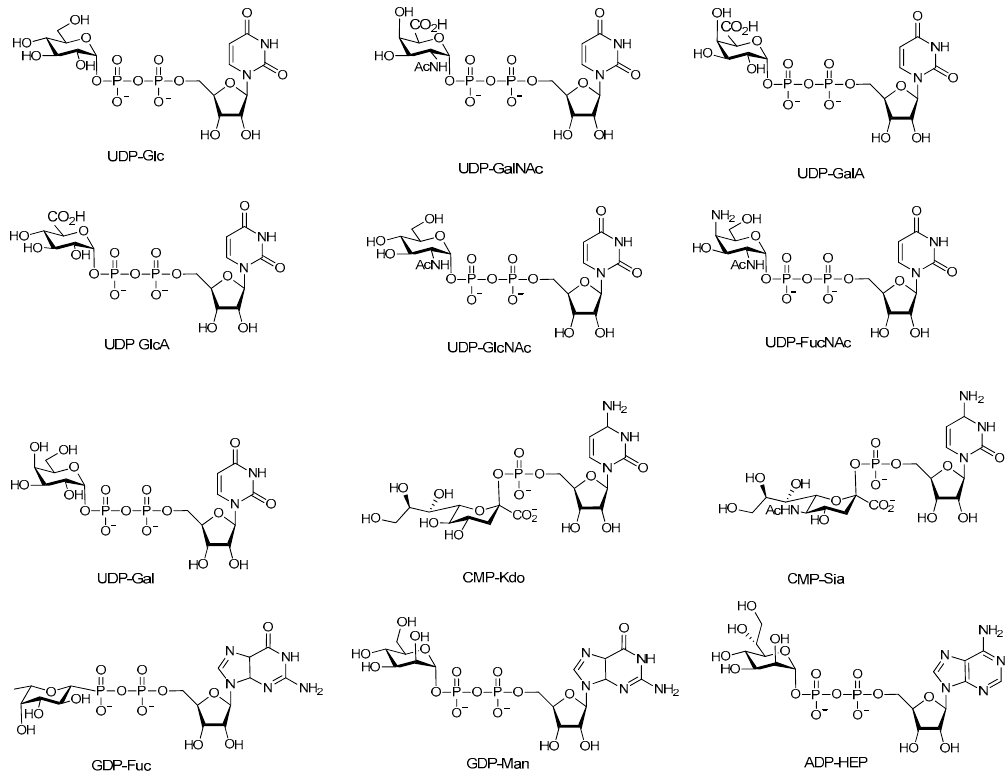
Figure 2. Common sugar nucleotides found in all kingdoms of life. Abbreviations: UDP-Glc, UDP-glucose; UDP-GalNAc, UDP- N -acetyl-2-deoxy- d -galactosamine; UDP-GalA, UDP- d -galacturonic acid; UDP-GlcA, UDP- d -glucuronic acid; UDP-GlcNAc, UDP- N -acetyl-2-deoxy- d -glucosamine; UDP-FucNAc, UDP- N -acetyl- l -fucosamine; UDP-Gal, UDP- d -galactose; CMP-Kdo, CMP-3-deoxy- d - manno-octulosonate; CMP-Sia, CMP- N -acetylneuraminic acid; GDP-Fuc, GDP- l -fucose; GDP-Man, GDP- d -mannose; ADP-HEP, ADP- l - glycero - d - manno